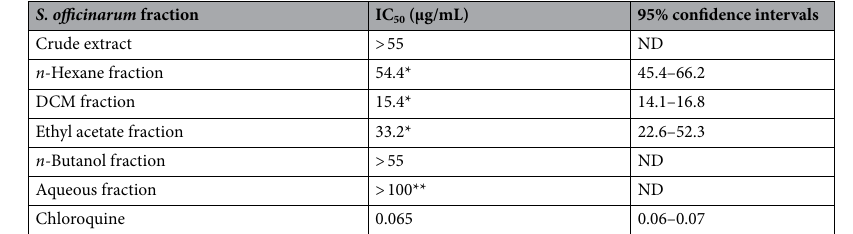
Table 1. In vitro antiplasmodial activity of S. officinarum extracts and fractions against chloroquine resistant (Dd2) strains of P. falciparum. Values expressed as IC 50 (µg/mL) ± standard deviation (n = ≥ 6). ND not determined. *Estimated IC 50 using GraphPad prism. **IC 50 greater than the highest concentration